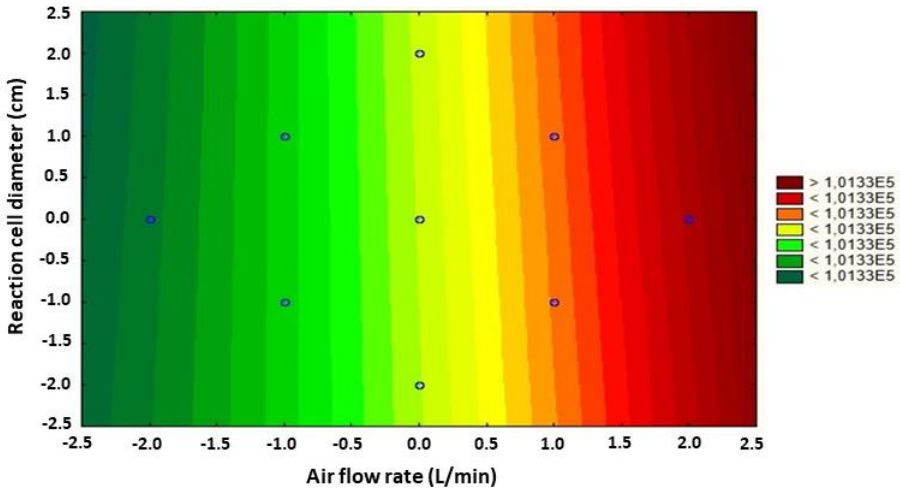
Figure 24. 2D contour graph of interaction effects of reaction cell diameter and air flow rate on the internal pressure for the upper air inlet and outlet geometry.